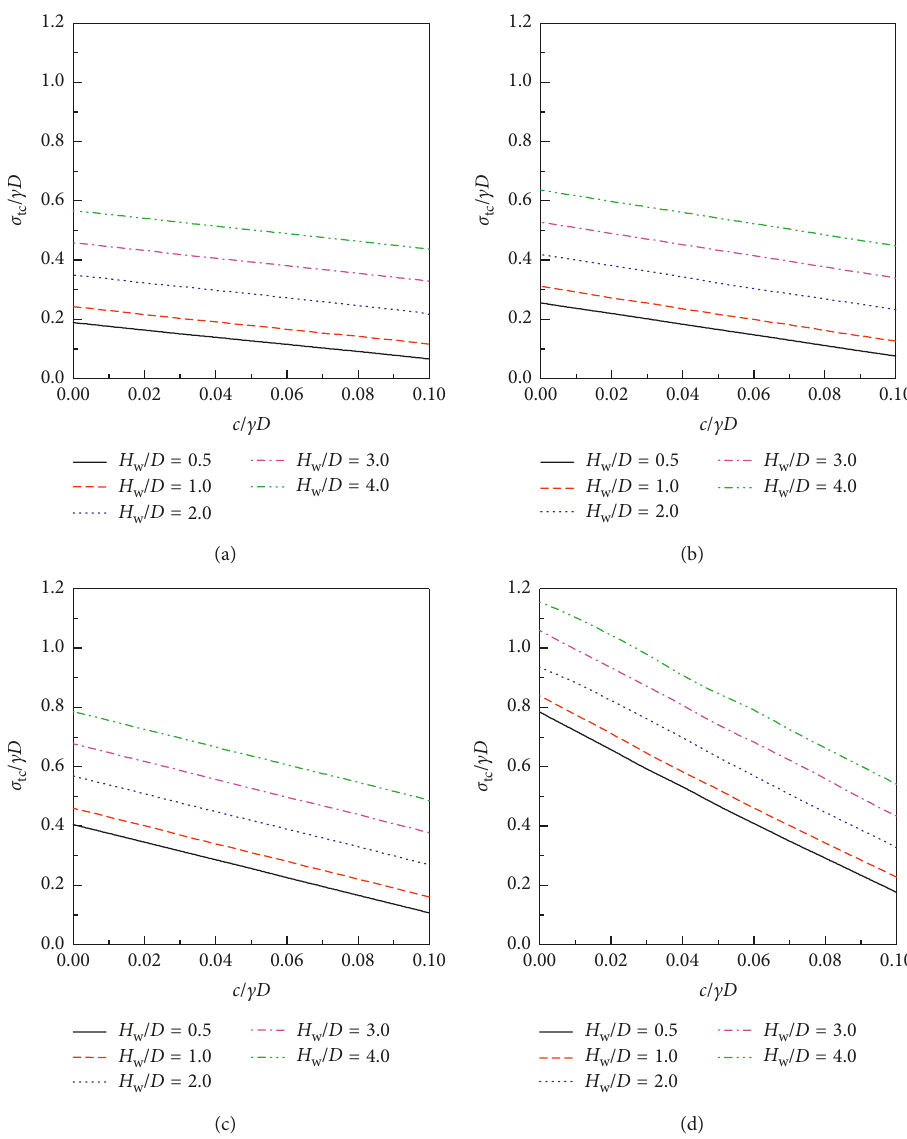
Figure 12: Stability charts of the critical pressure supported on the tunnel face under the pore water pressure r (c) φ 20 ° . (d) φ 10 ° (cid:29) (cid:29)